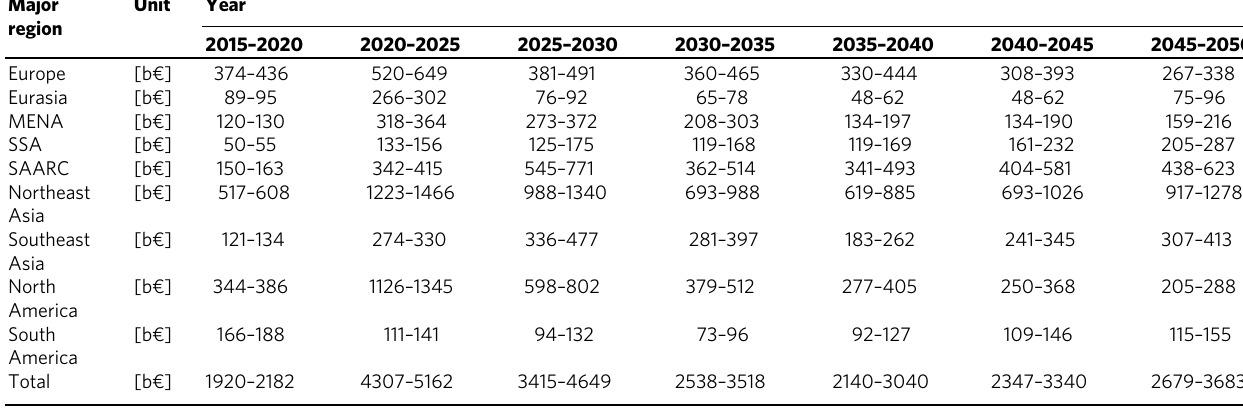
Table 1 Capital expenditures in the power sector for the transition from 2015 to 2050 Major